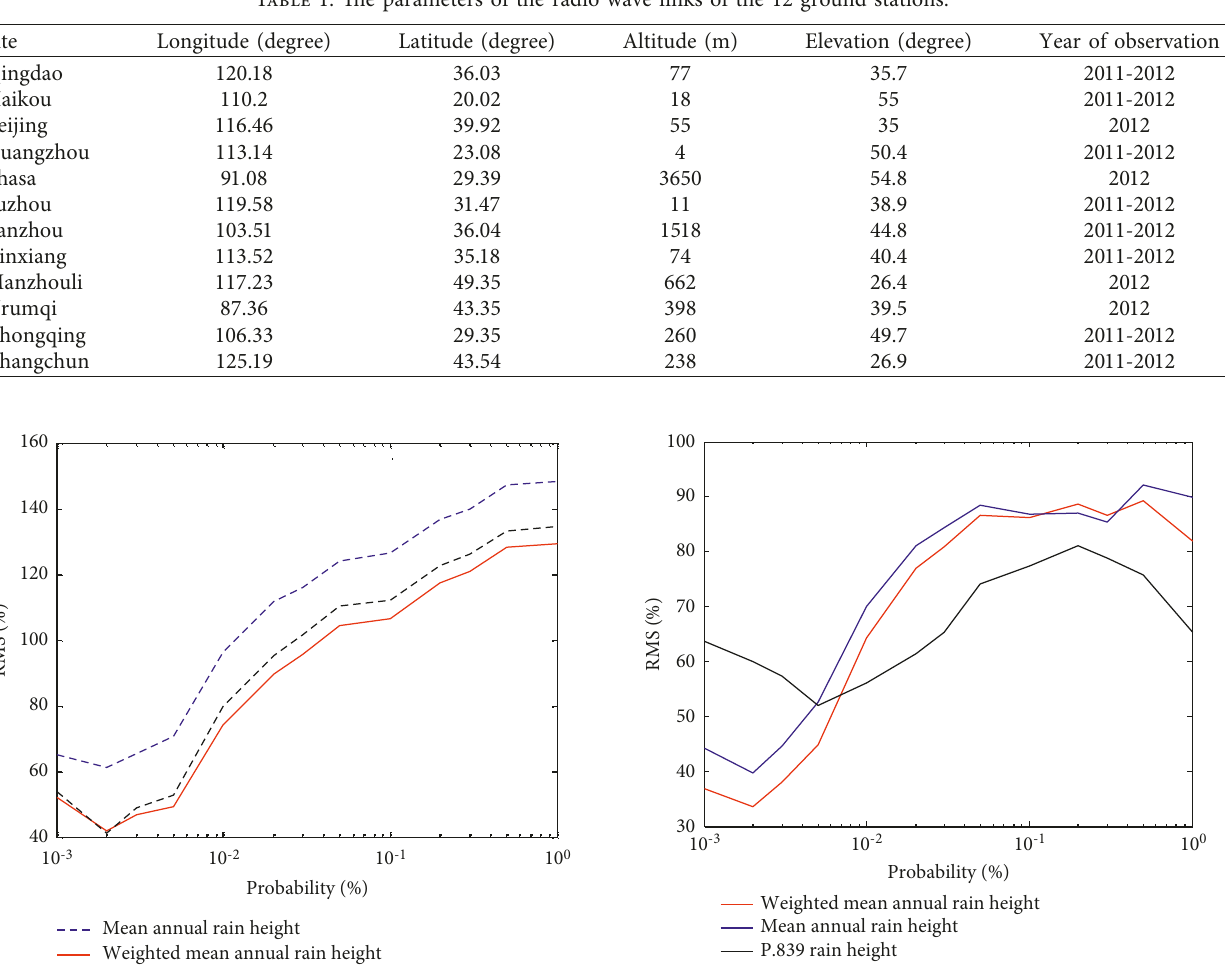
Figure 13: The comparison of rain attenuation prediction with different rain heights and corresponding adjustment